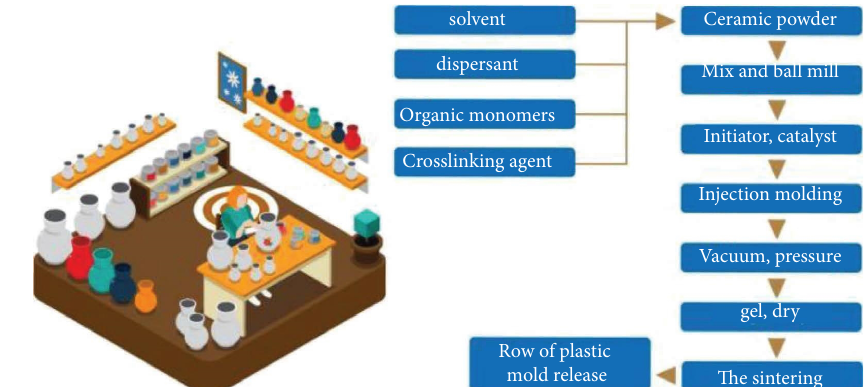
Figure 1: Gel injection molding process fow.